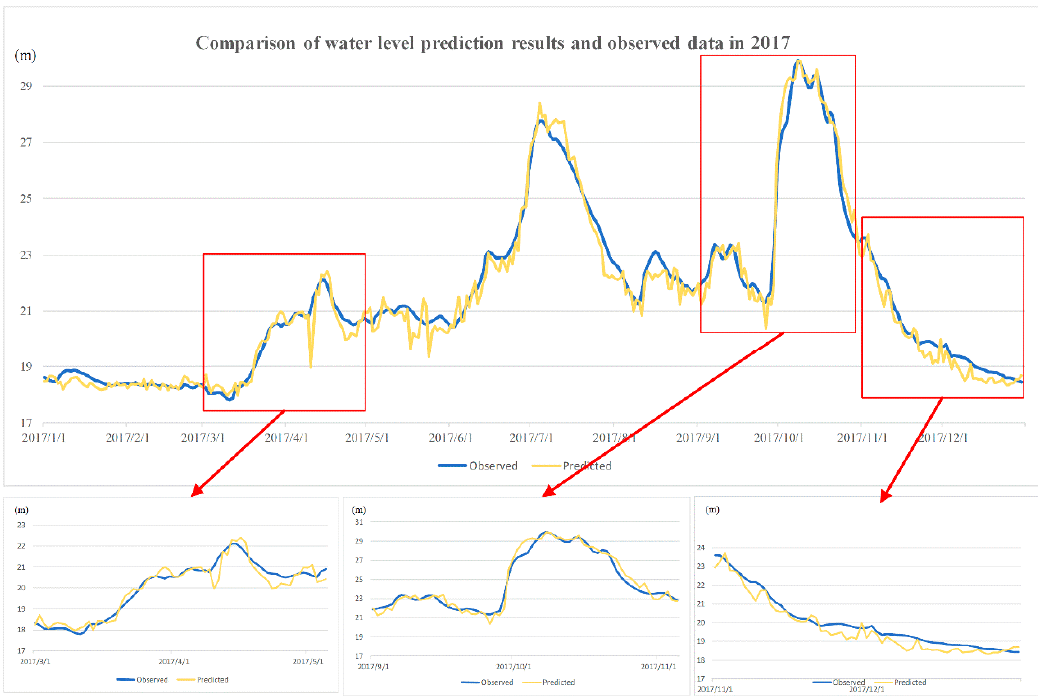
Figure 6. The water level results predicted by the IGA-BPNN and the comparison results between the predicted and observed data of partial periods.